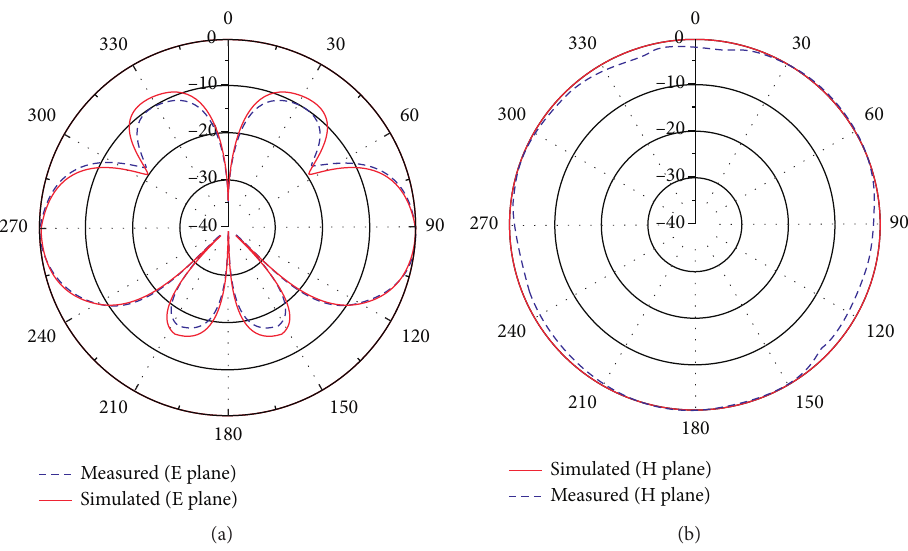
Figure 9: Measured and simulated radiation patterns at (a) E plane and (b) H Table 1: Comparison of other omnidirectional antennas and this work. Ref.